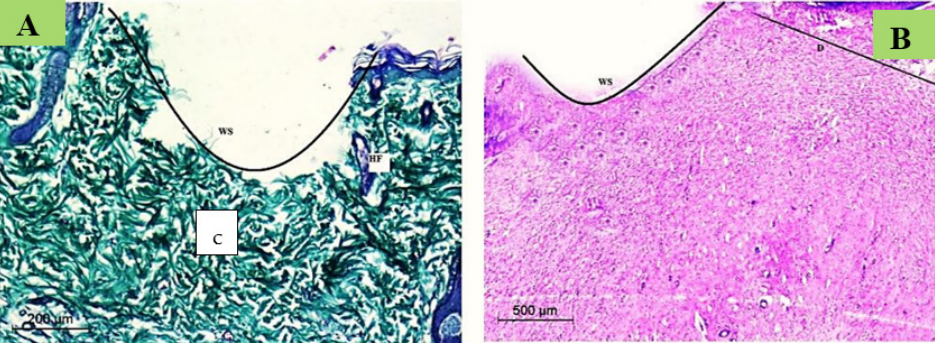
Figure 11. Photomicrograph of the histological appearance of immediate skin wounded stained with H&E ( A ) and Massons Trichrome ( B ). In which: D (Dermis); WS (wound site); c (collagen); HF (hair follicle) .